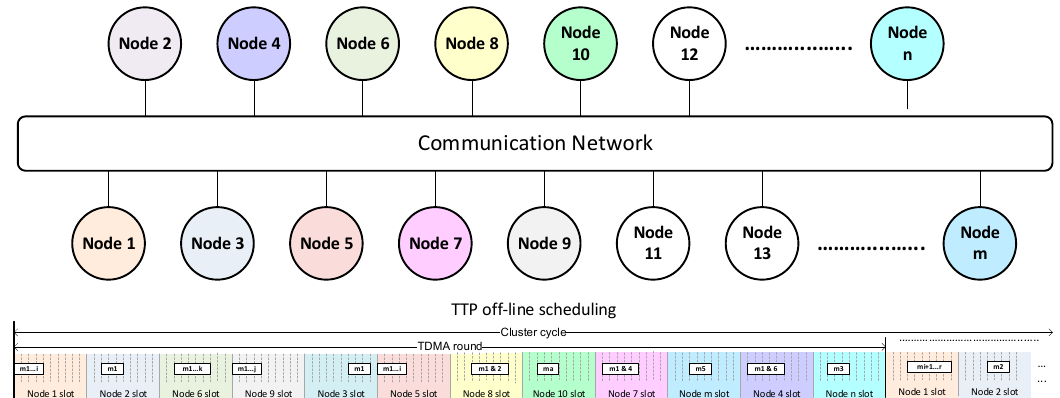
Figure 2. Time-driven messaging in the Time-Triggered Protocol (TTP).